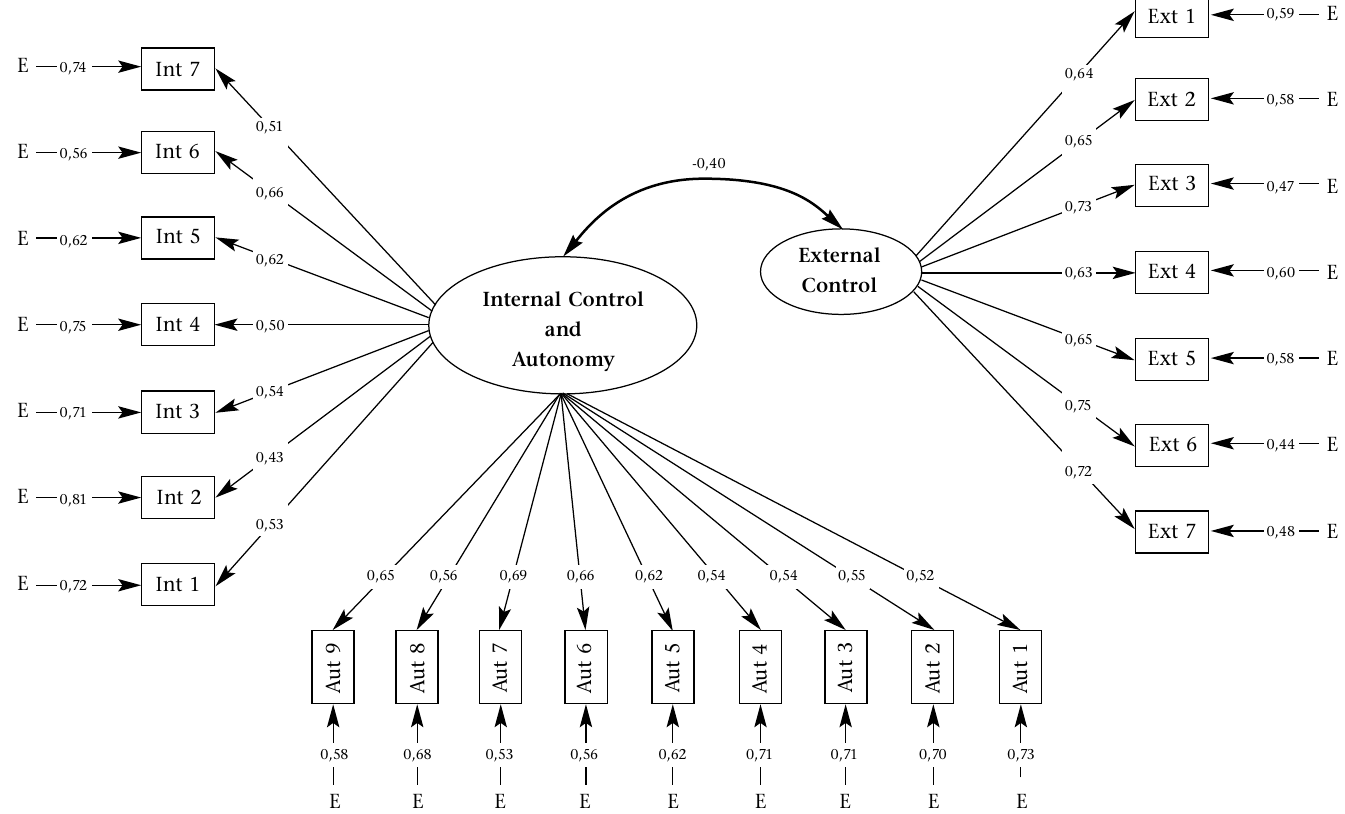
Figure 6: Standardised parameters for the two-factor LCI model in respect of the